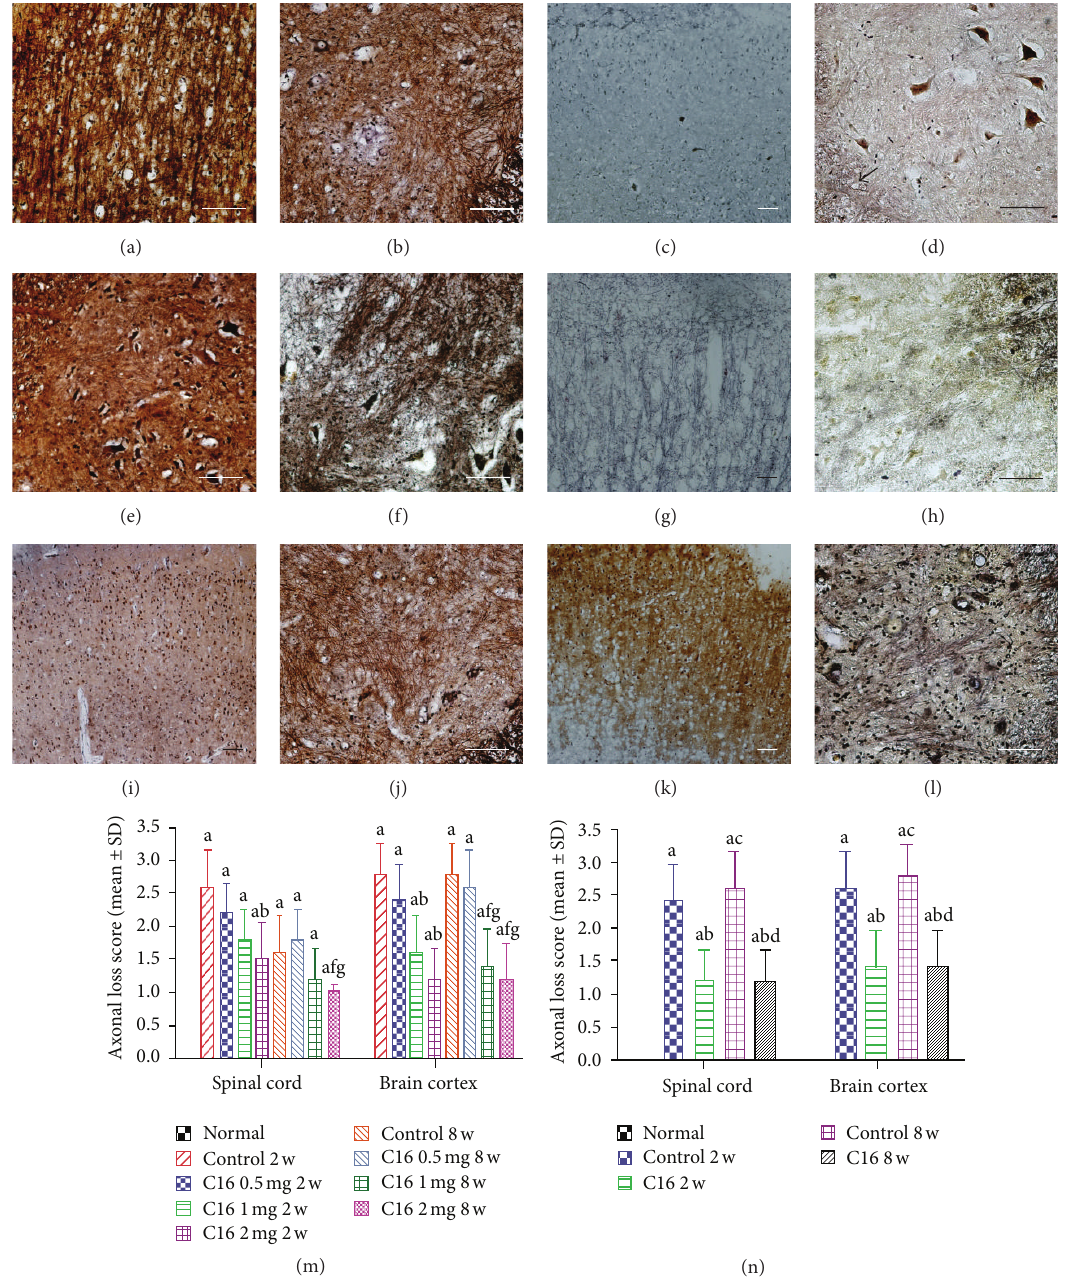
Figure 5: C16 treatment alleviated axonal loss in spinal cord and cerebral cortex revealed by Bielschowsky staining both at weeks 2 and 8 after immunization. ((a), (c), (g), (i), and (k) coronal sections of motor cortex; (b), (d), (e), (f), (h), and (j) traverse sections through the lumbar spinal cord); bar = 100 𝜇 m. At week 2 after immunization, normal rats group ((a), (b)), vehicle control rats ((c) axons were undergoing gradual loss and exhibiting deformed and ovoid formation; (d) an arrow shows the axon loss in white matter); 2mg/per day C16 treated EAE rats (e) and C16 late treated EAE rats (f). At week 8 after immunization, vehicle control rats ((g), (h)), 2 mg/per day C16 treated EAE rats ((i), (j)). C16 late treated EAE rats ((k), (l)). (m) Medium to high-dose C16 treatment prevented axon loss by an estimate of axonal loss score. a 𝑃 < 0.05 versus normal rats; b 𝑃 < 0.05 versus vehicle control rats at week 2 after immunization group; f 𝑃 < 0.05 versus vehicle control rats at week 8 after immunization. g 𝑃 < 0.05 versus 0.5 mg/per day C16 treated EAE rats at week 8 after immunization. (n) C16 late treatment prevented demyelination to a certain extent by axonal loss score. a 𝑃 < 0.05 versus normal rats; b 𝑃 < 0.05 versus vehicle control rats at week 2 postimmunization group; c 𝑃 < 0.05 versus C16 treated EAE rats at week 2 postimmunization group; d 𝑃 < 0.05 versus vehicle control rats at week 8 after